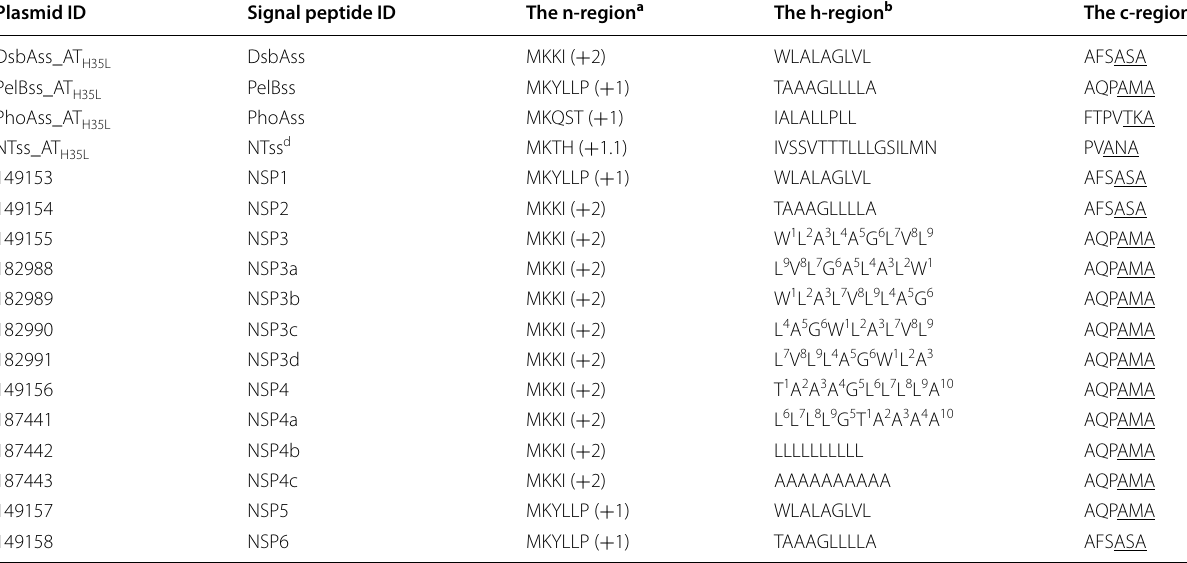
Table 2 Amino acid sequences of bacterial and novel signal peptides used in this study